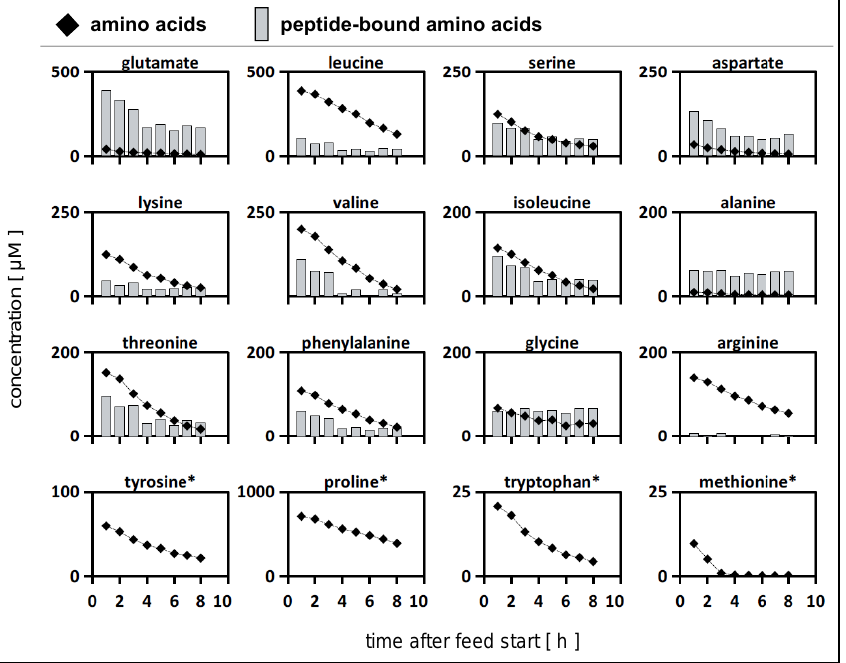
Figure 3. Amino acid profiles in the compartment containing Streptococcus thermophilus during co- cultivation with Lactobacillus delbrueckii subs. bulgaricus in the tube bioreactor system. ( rhomb ) Ex- tracellular amino acid concentrations (µM) in the compartment containing S. thermophilus during the continuous mode. ( bars ) Extracellular peptide-bound amino acid concentrations (µM) in the compartment containing S. thermophilus during the continuous mode. S. thermophilus was cultivated in co-culture with L. bulgaricus in the tube bioreactor system containing synthetic medium (SM) with casein and glucose in the L. bulgaricus compartment and SM with glucose in the S. thermophilus com- partment. * Profile data for these peptide-bound amino acids not measured. The strength of the 2cs is that it allows the calculation of strain-specific amino acid rates by the individual analysis of sample concentrations (Table S3 in Supplementary Ma- terials). As shown in Figure 4, positive values indicate amino acid release regardless of the precursor origin, that is, casein or glucose, whereas negative numbers correlate with amino acid consumption. By trend, both strains released amino acids during the first 3 h before metabolic productivity declined or even before consumption occurred. In particu- lar, L. bulgaricus released amino acids (Table S3 in Supplementary Materials) based on its high proteolytic activity. Glutamate, aspartate, and alanine were only produced by L. bul- garicus and consumed by S. thermophilus during the first 3 h. Another exception was me- thionine, which was consumed by both strains in the continuous mode.